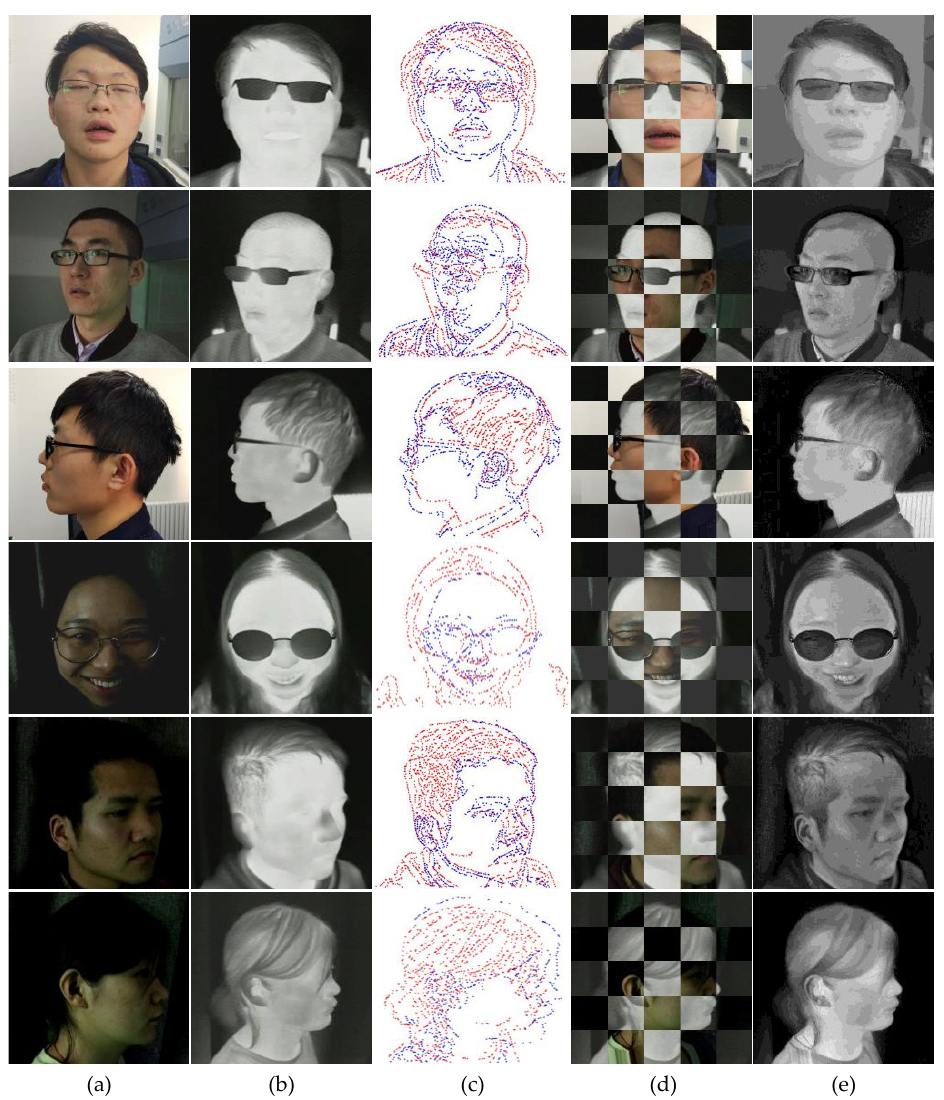
Figure 7. Registration and fusion results of our method considering six typical unregistered visible and infrared image pairs in the self-built multi-spectral face datasets. ( a ) Visible image; ( b ) Thermal infrared image; ( c ) Canny edge maps; ( d ) Superimposed checkerboard pattern of visible and infrared images; ( e ) Fusion results.